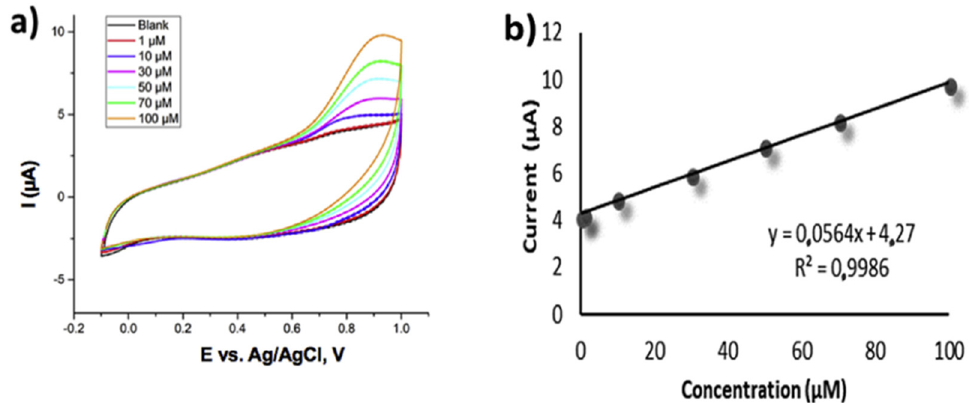
Figure 4. ( a ) CV responses of different concentrations of arsenic (III) in phosphate buffer solution pH 3; scan rate 50 mV s − 1 at Ir-BDD prepared using complete step deposition. ( b ) Graph depicts the dependence of current responses on arsenic (III) concentrations (reproduced with the permission of [70]).